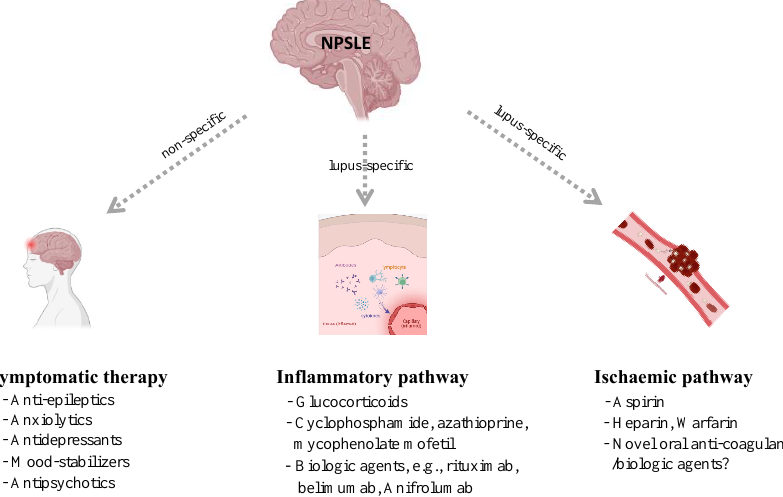
Figure 2. Management for patients with neuropsychiatric systemic lupus erythematosus (NPSLE). Created with biorender.com.